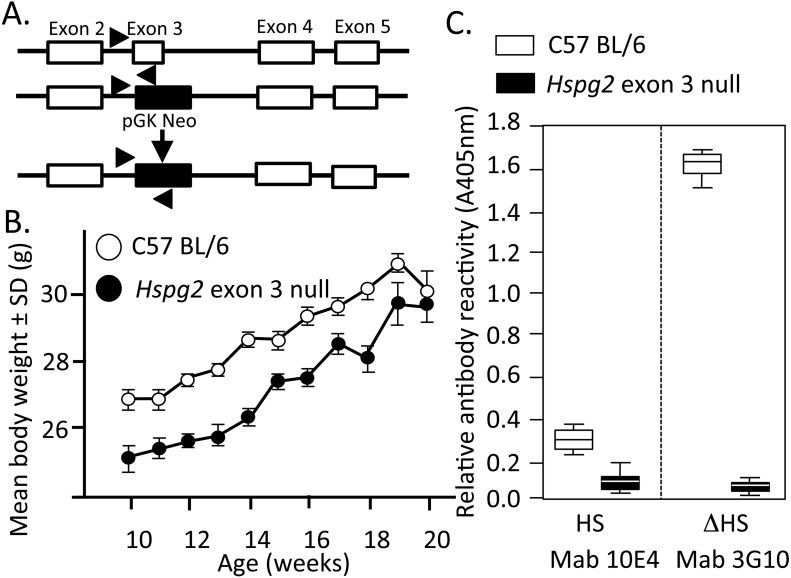
Genomic organisation, weights of perlecan exon 3 null and wild type mice and HS contents of perlecan from the two mouse genotypes.Genomic organisation of exons 2–5 of the WT and Hspg2Δ3−∕Δ3− mice (A). Body weights of male WT (open symbols) and Hspg2Δ3−∕Δ3− mice (closed symbols) from 10–20 weeks of age (B). ELISA analysis of perlecan GAG side chains using MAb 10E4 to native HS and MAb 3G10 to the Δ HS stub epitope generated by heparitinase III pre-digestion demonstrating an absence of HS in the mutant perlecan (C).